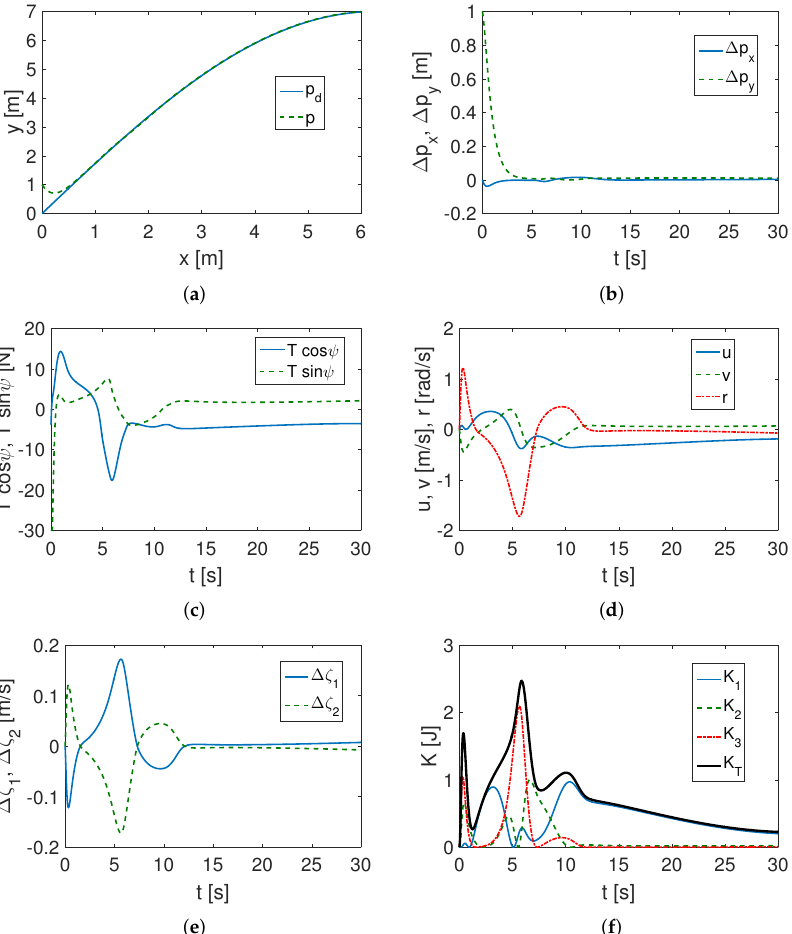
Figure 2. Simulation results for sine trajectory: ( a ) desired ( p d ) and realized ( p ) trajectory; ( b ) position errors ∆ p x , ∆ p y (in inertial frame); ( c ) input signals components (applied force) T cos ψ , T sin ψ ; ( d ) actual velocities u , v , r ; ( e ) changes in quasi-velocity ( ∆ ζ 1 , ∆ ζ 2 ); ( f ) changes in kinetic energy ( K 1 , K 2 , K 3 , K T ) during